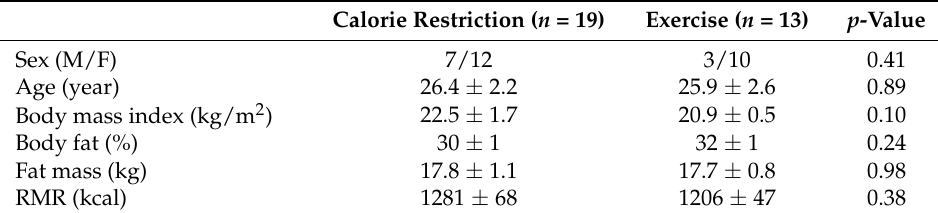
Table 1. Subject